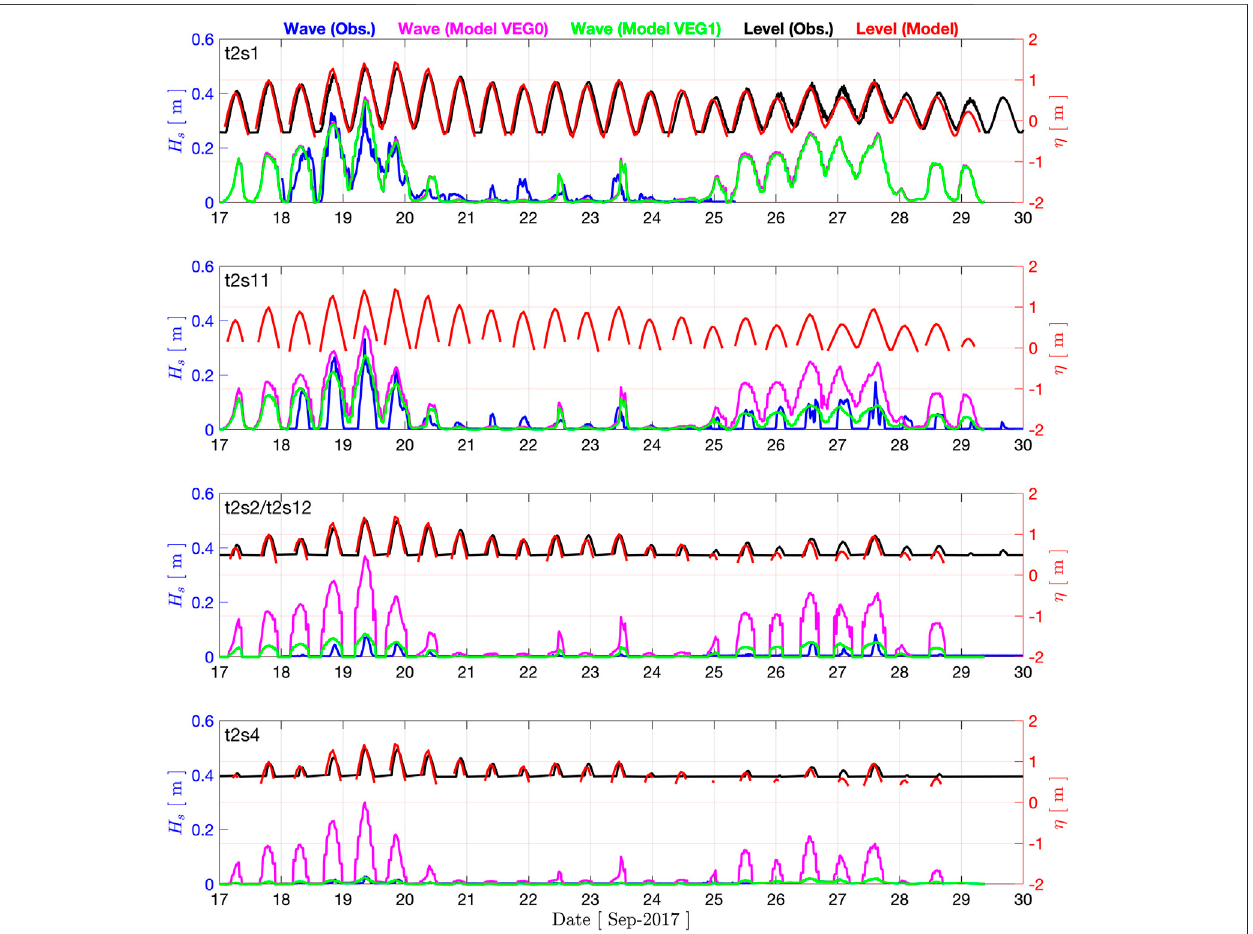
FIGURE 7 | Wave and storm surge Models ’ validation at the wave and water level gauges locations (transect AA) for signi fi cant wave height H s (observation: blue; WW3 without wave – vegetation interaction: magenta; and WW3 with wave – vegetation interaction: green) and water level elevation η (observation: black; and ADCIRC: